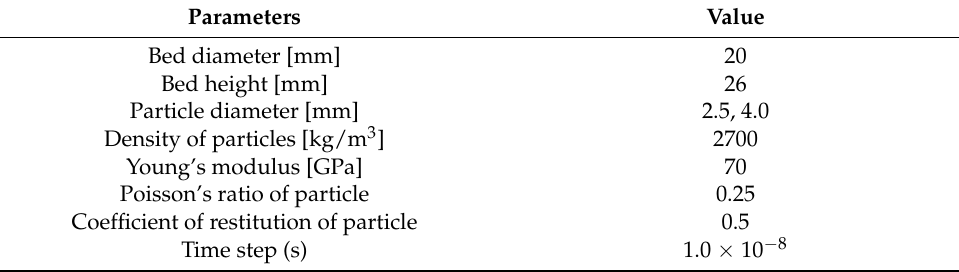
Table 2. Parameters for CFD simulation.